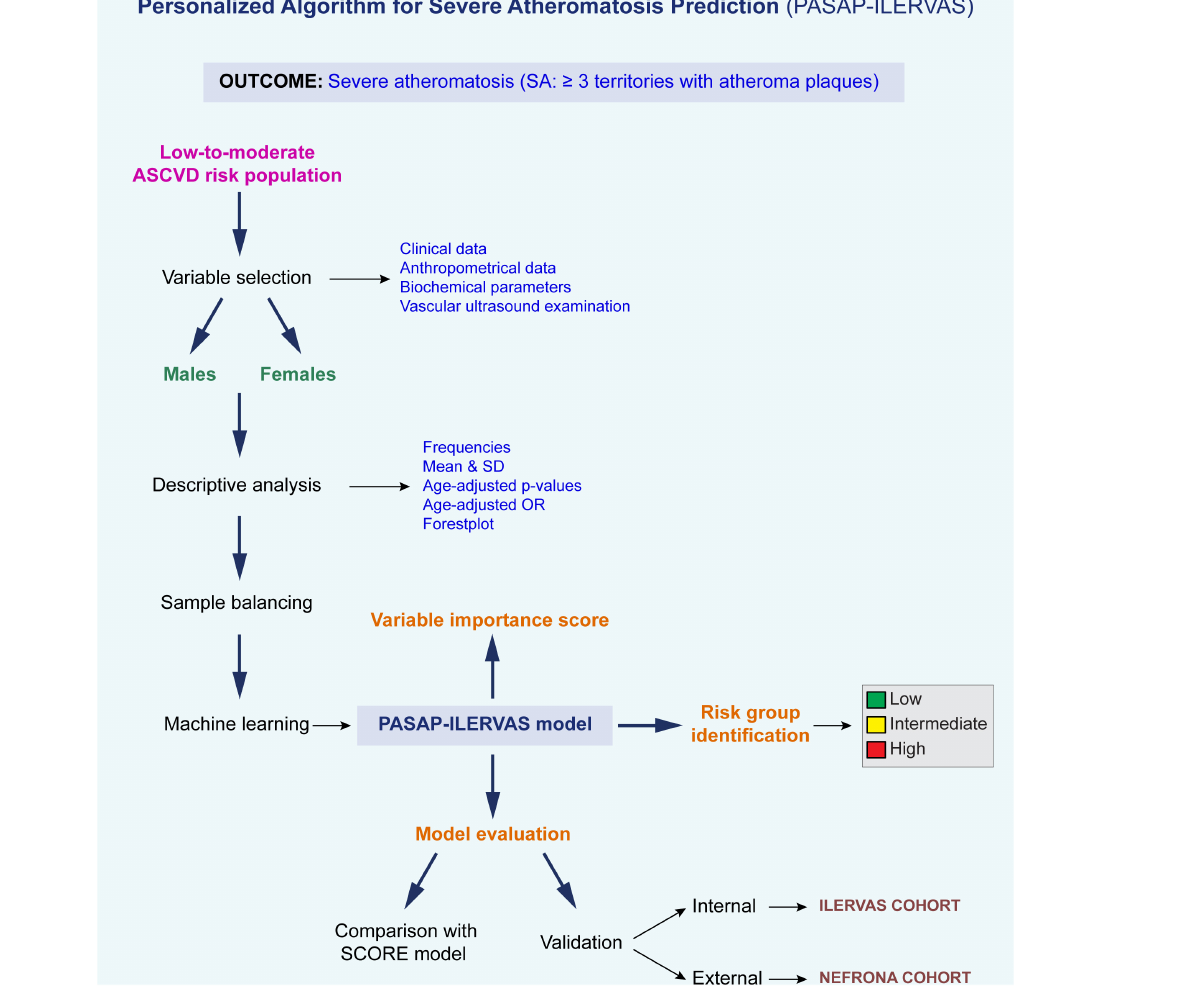
Frontiers in Cardiovascular Medicine |